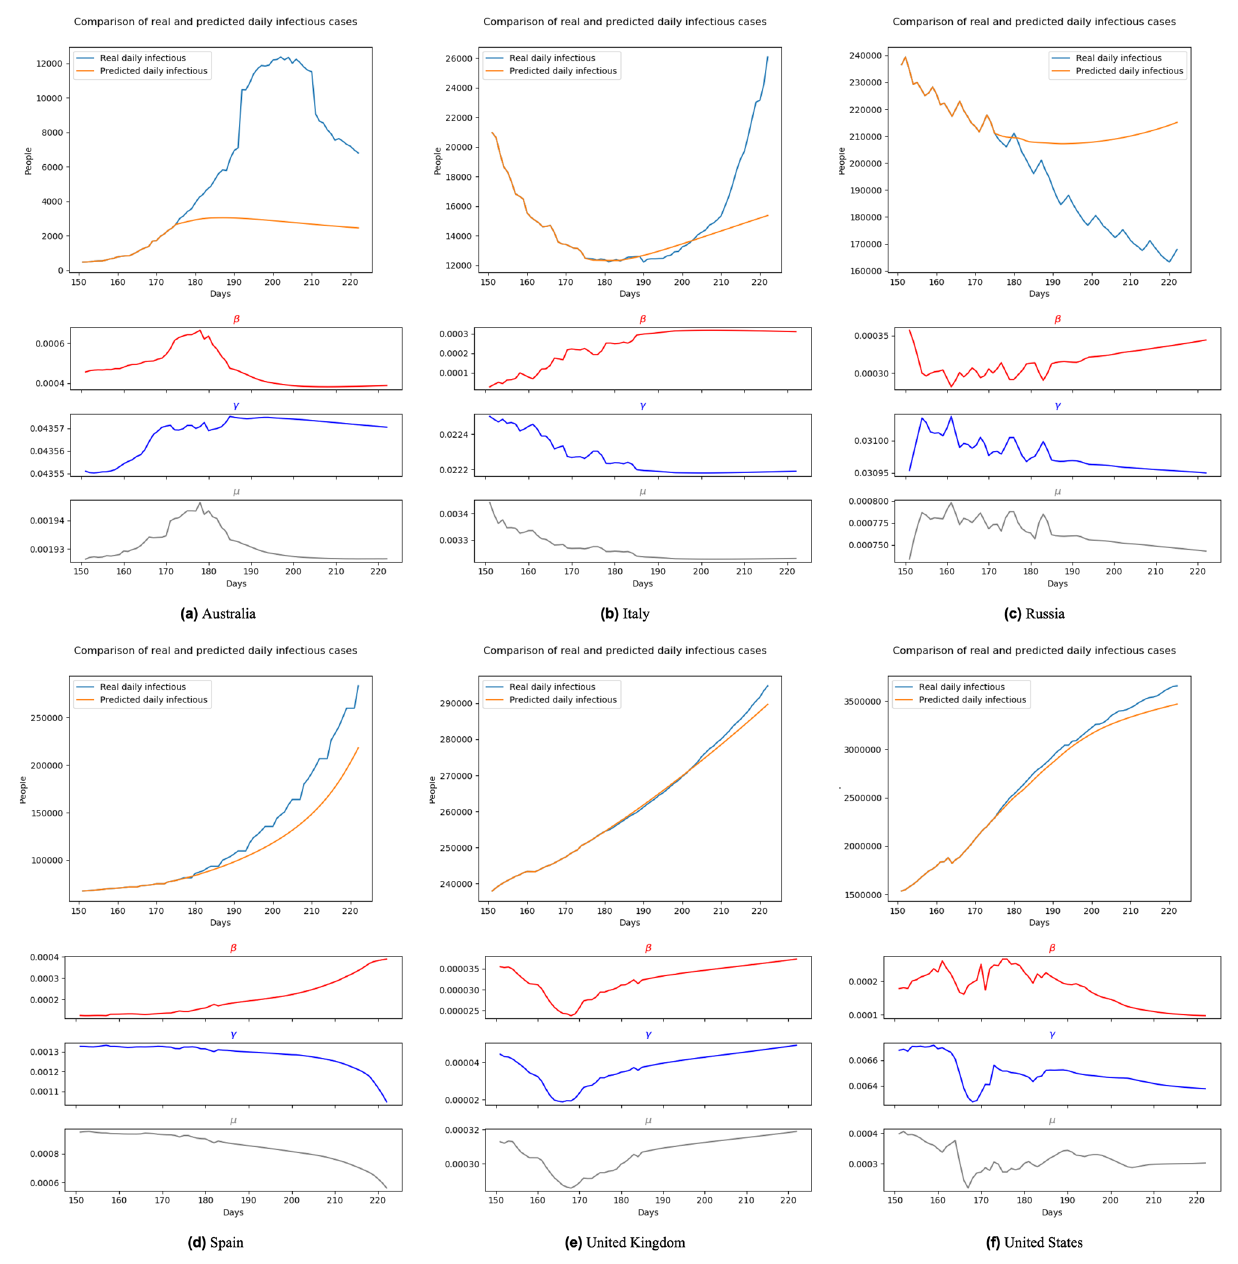
Figure 11. Forecasting results with transition rates of 176th–222nd day (Jul. 16th 2020–Aug. 31st 2020) using data of 166th–175th day (Jul. 6th 2020–Jul. 15th